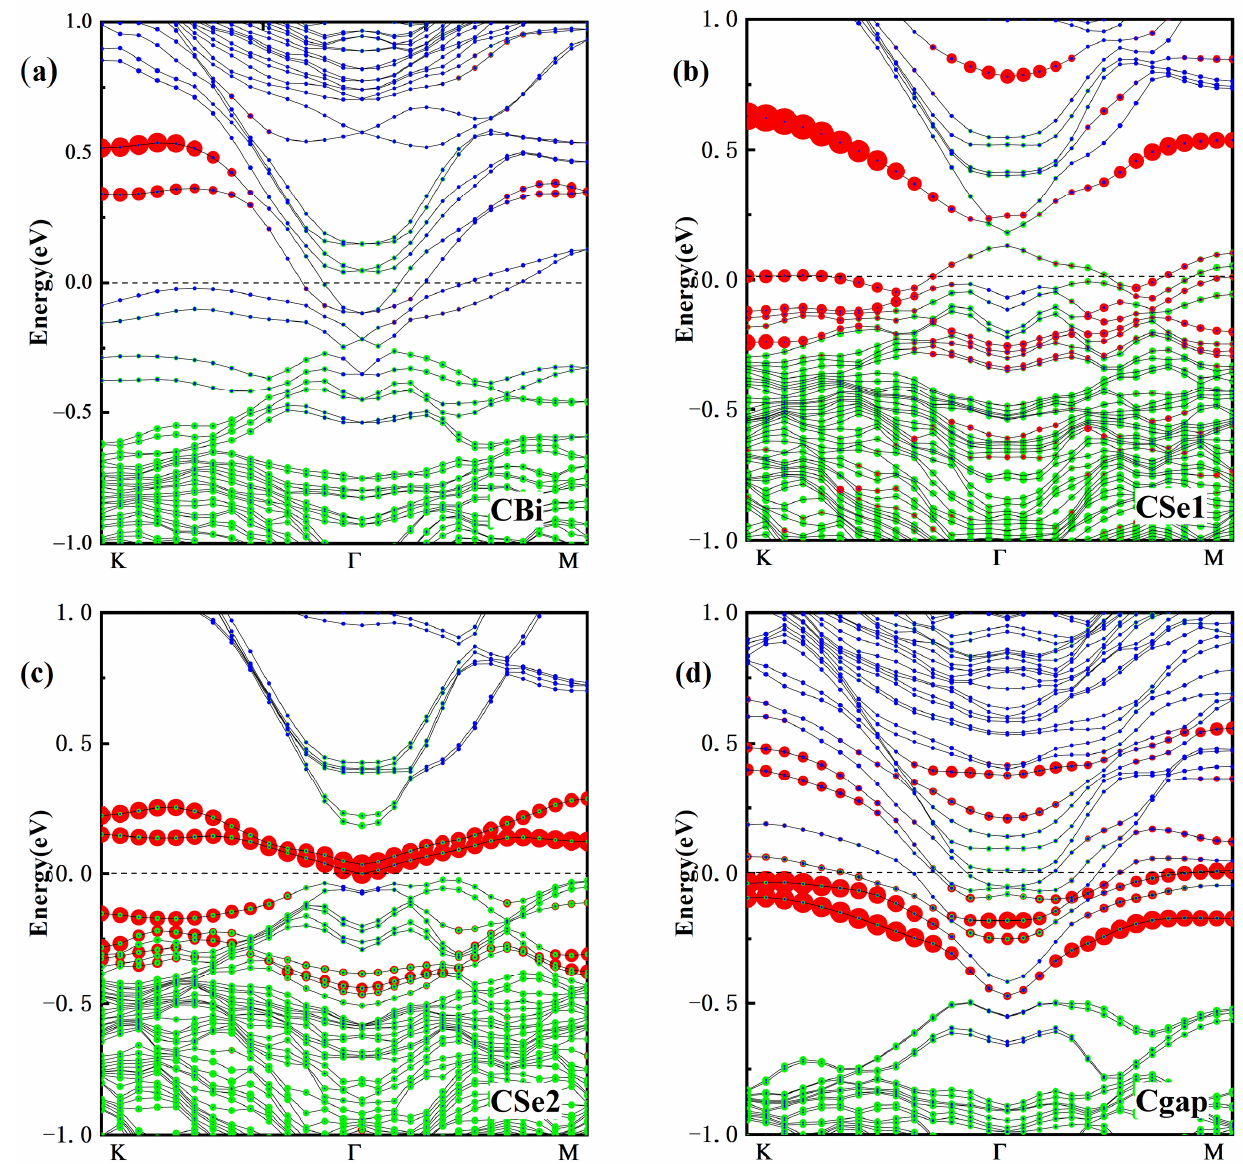
Figure 3. Band structure of C doping Bi 2 Se 3 : ( a ) C doping at Bi site, ( b ) C doping at Se1 site, ( c ) C doping at Se2 site, and ( d ) C doping at gap site. The black line is the total band, the red point is the contribution from C atom, the green point is the contribution from Se atom and the blue point is the contribution from Bi atom.